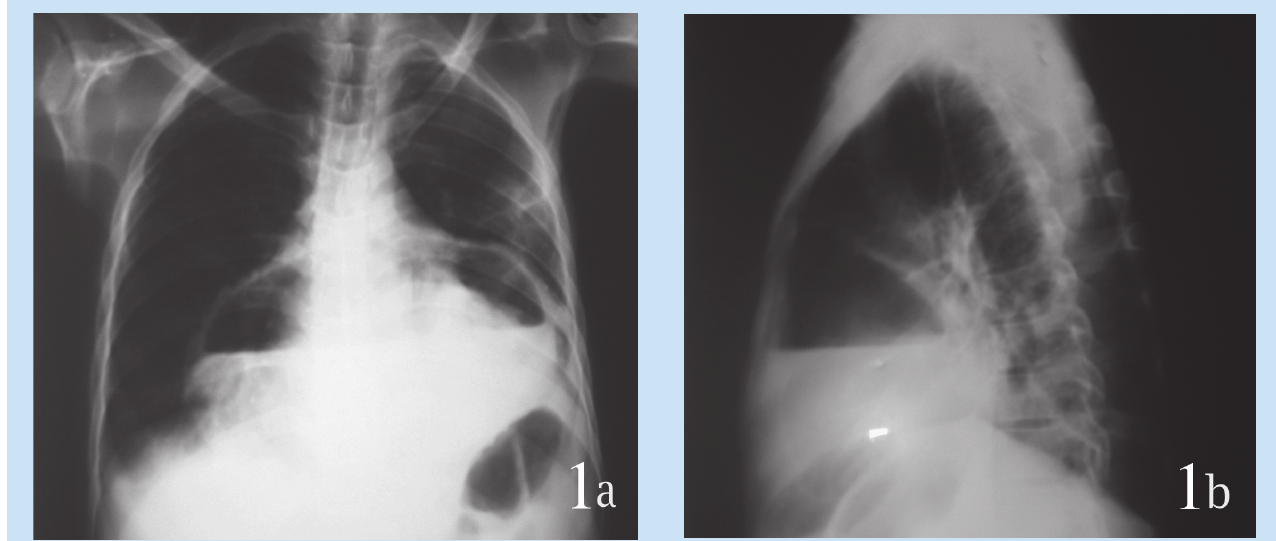
Fig. 1a and b. Chest X-ray after pericardiocentesis. Hydropneumopericardium showing air/fluid level: frontal view (a) and side view